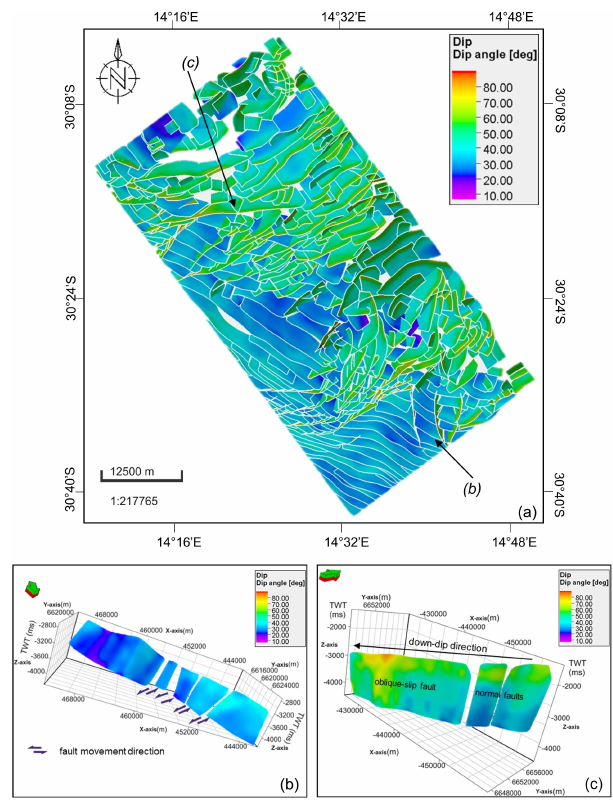
Figure 11. Structural framework faults interpreted in the study area showing (a) plan view of all dipping faults; (b) segmented shallow- dipping thrust fault showing left lateral (sinistral) slip motion of displacement in 3D; and (c) steeply dipping normal and oblique- slip fault extending between both the translational and down-dip compressional domains in